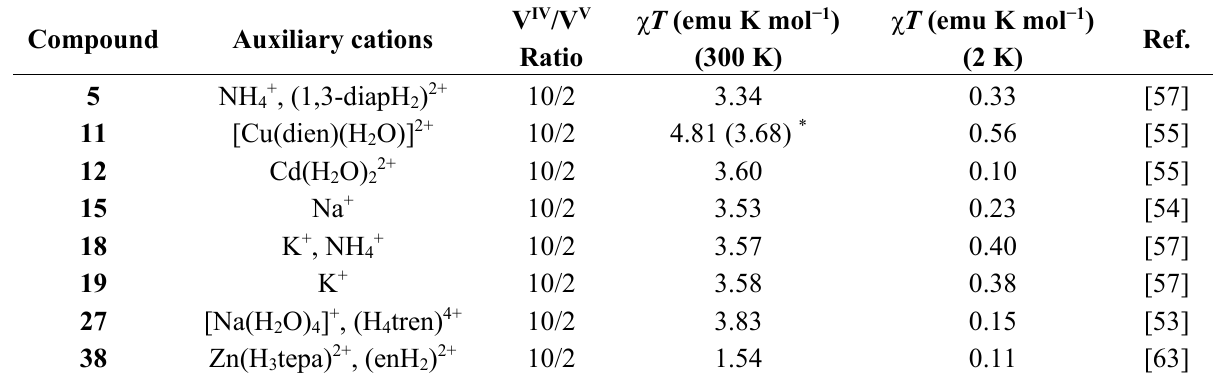
Table 6. List of the reported compounds with magnetic property studies.